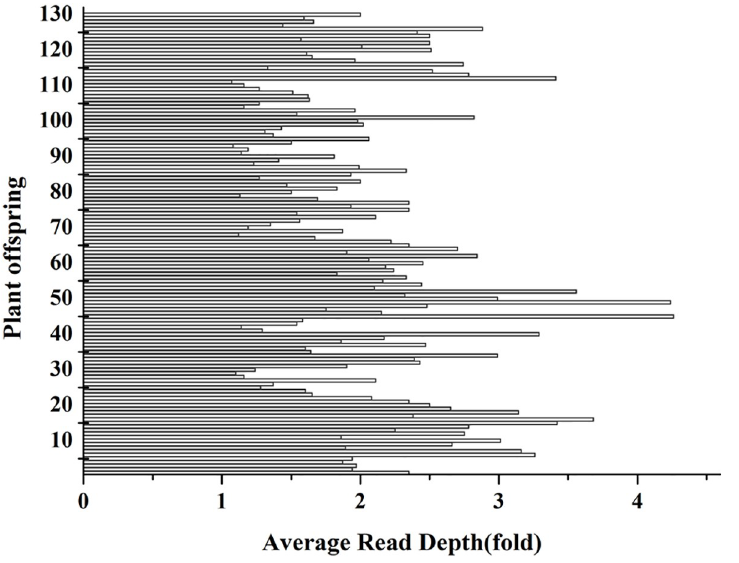
Fig 2. Clean reads number distribution of 130 hybrid offspring.